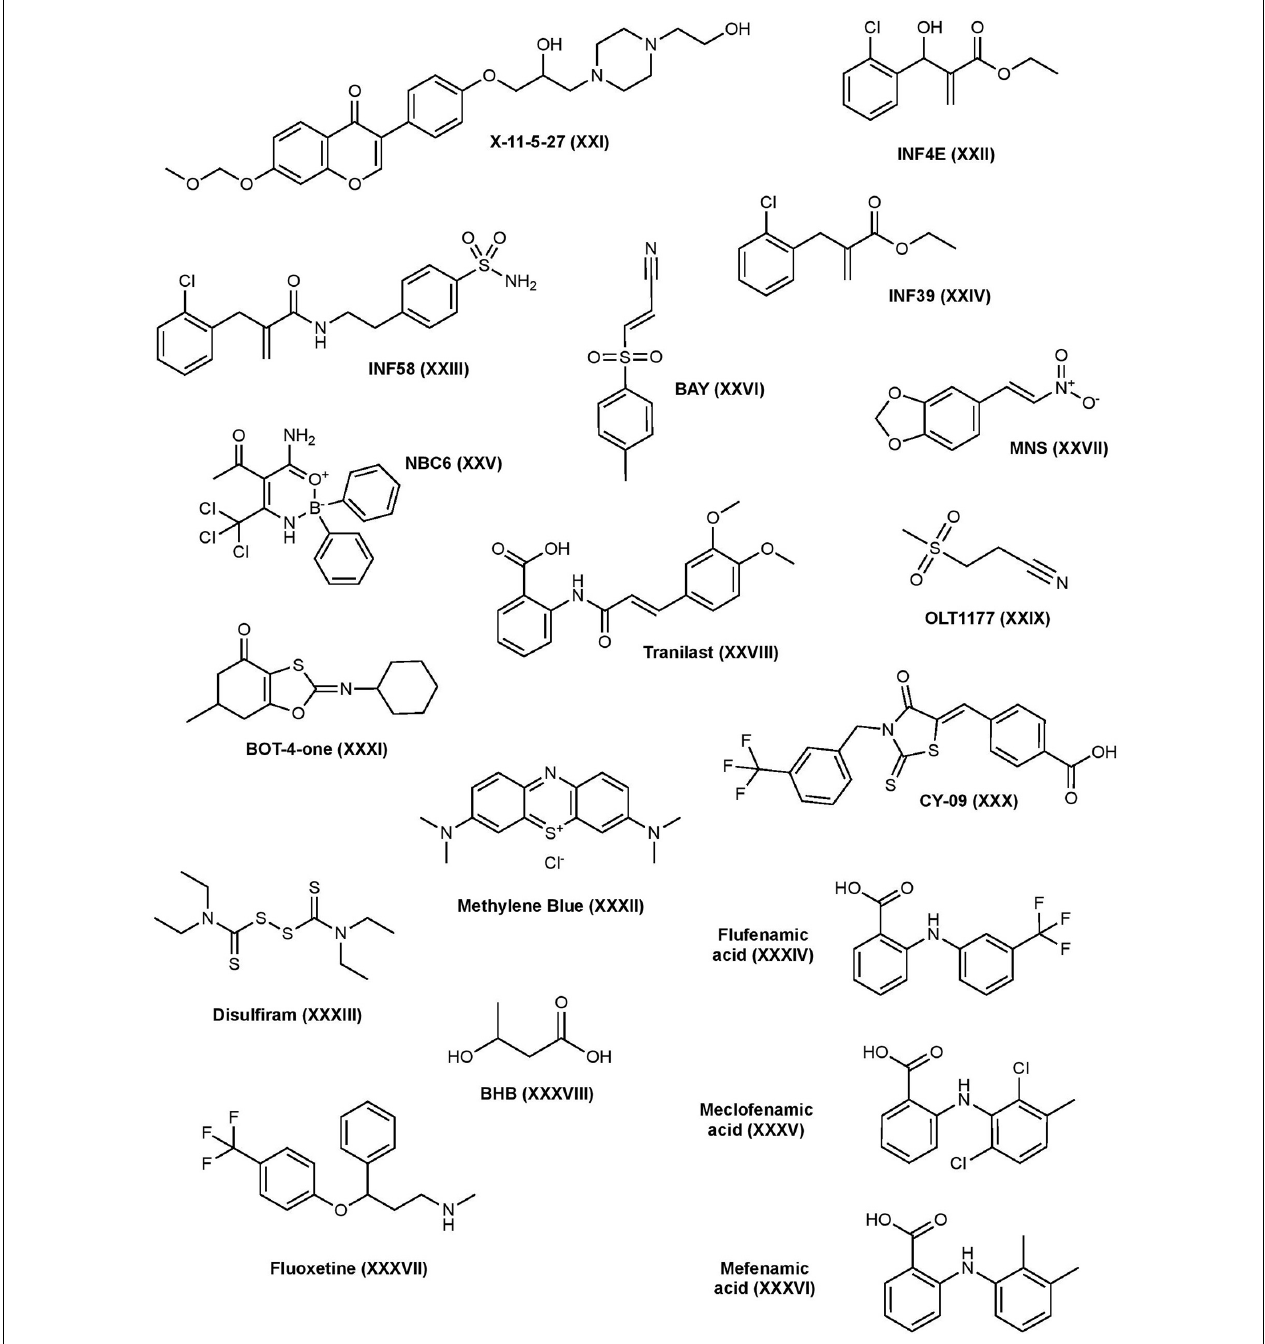
FIGURE 4 | Other NLRP3 inhibitors